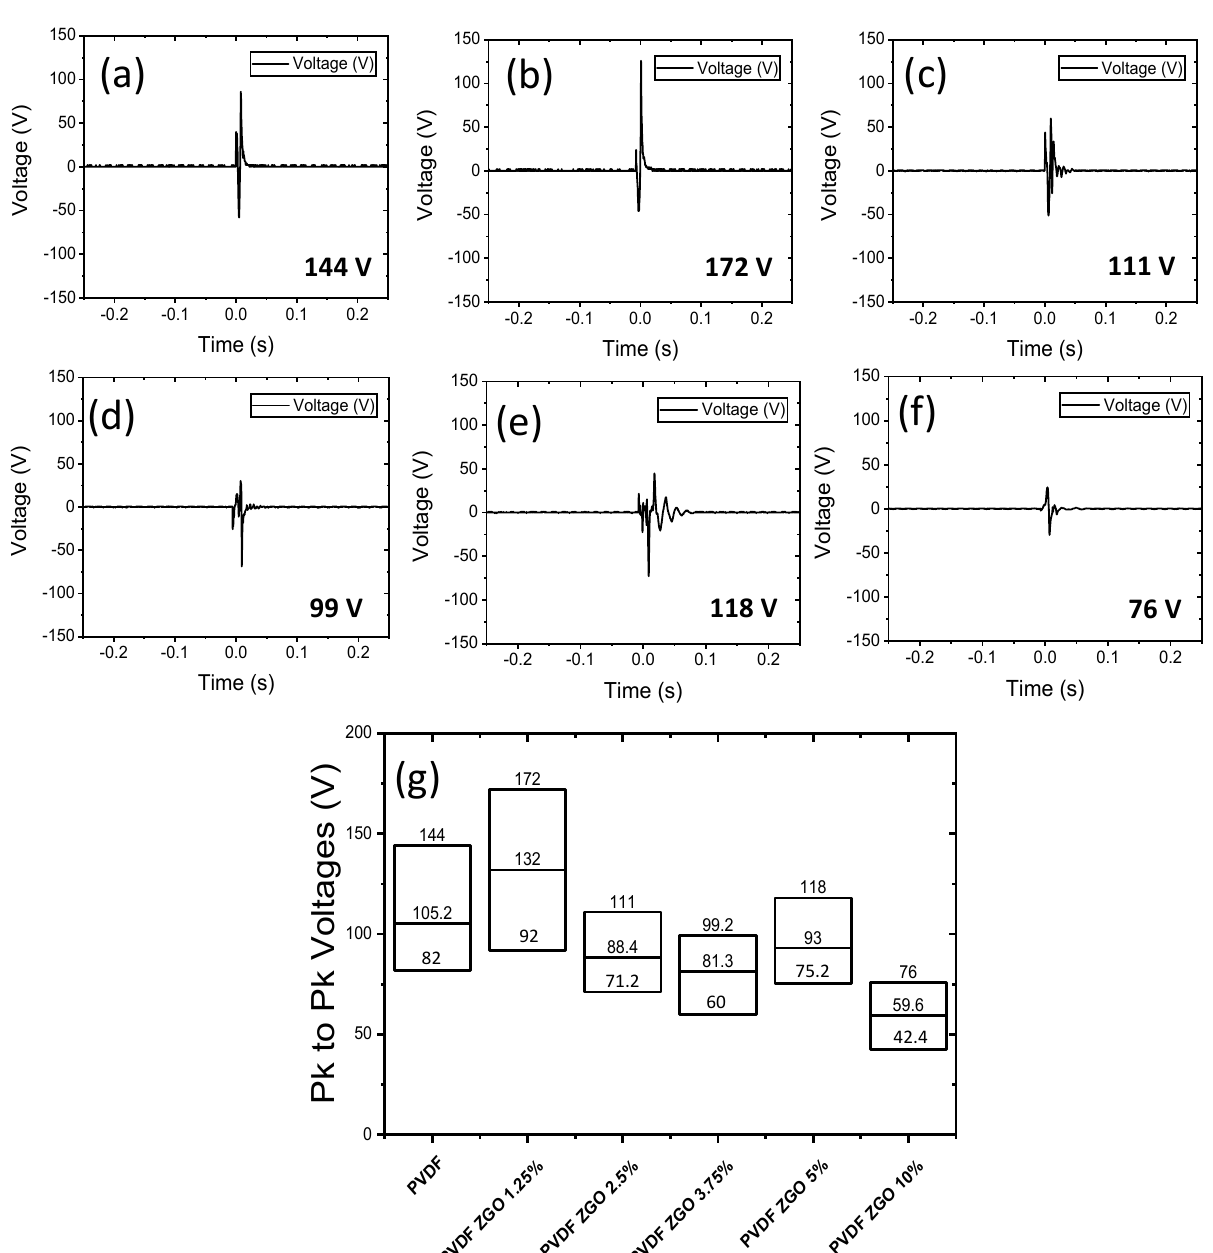
Figure 6. Highest peak-to-peak voltage produced during initial loading by ( a ) PVDF fiber, ( b ) PVDF-1.25 wt % ZGO, ( c ) PVDF-2.5 wt % ZGO, ( d ) PVDF-3.75 wt % ZGO, ( e ) PVDF-5 wt % ZGO, and ( f ) PVDF10 wt % ZGO; ( g ) histogram shows minimum, mean, and maximum peak-to-peak voltage produced by all fiber mat systems.